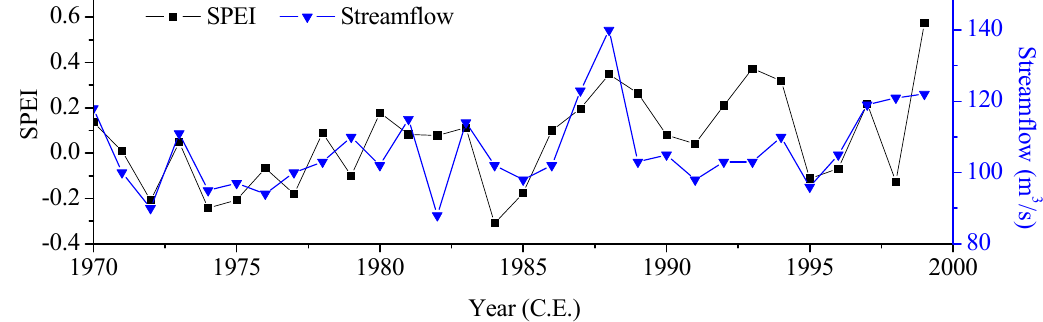
Figure 7. Comparison of the SPEI reconstruction and discharge of the Chu River.